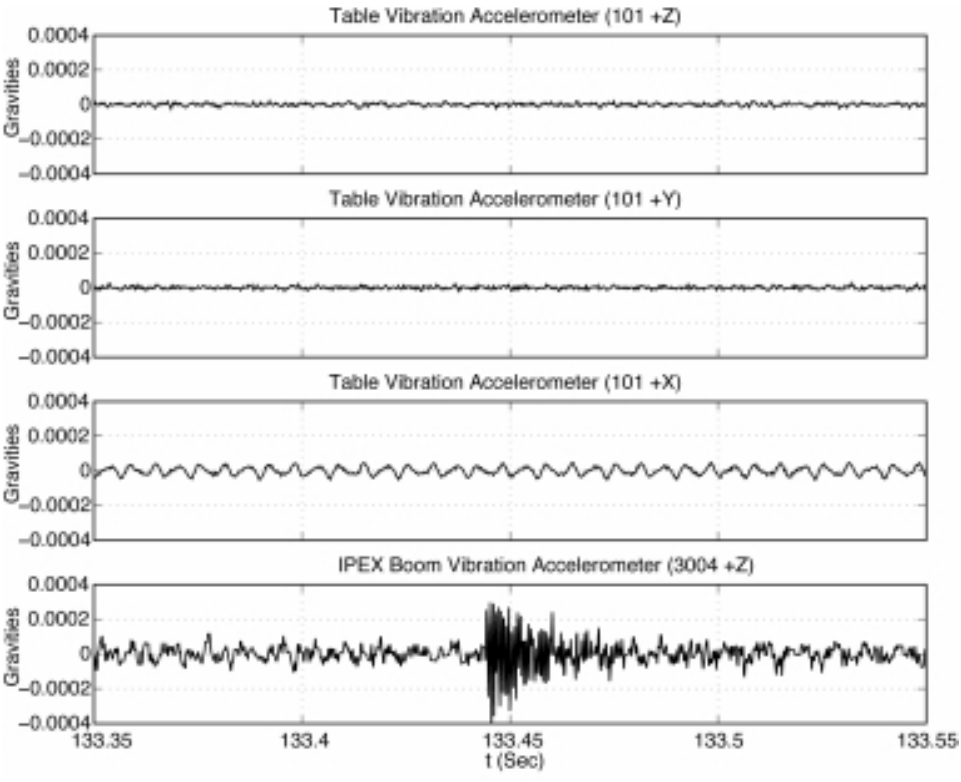
Fig. 7. Response at Node 3004 of Event 1 Compared to Corresponding Table Accelerometer Data (High Pass Filtered above 100